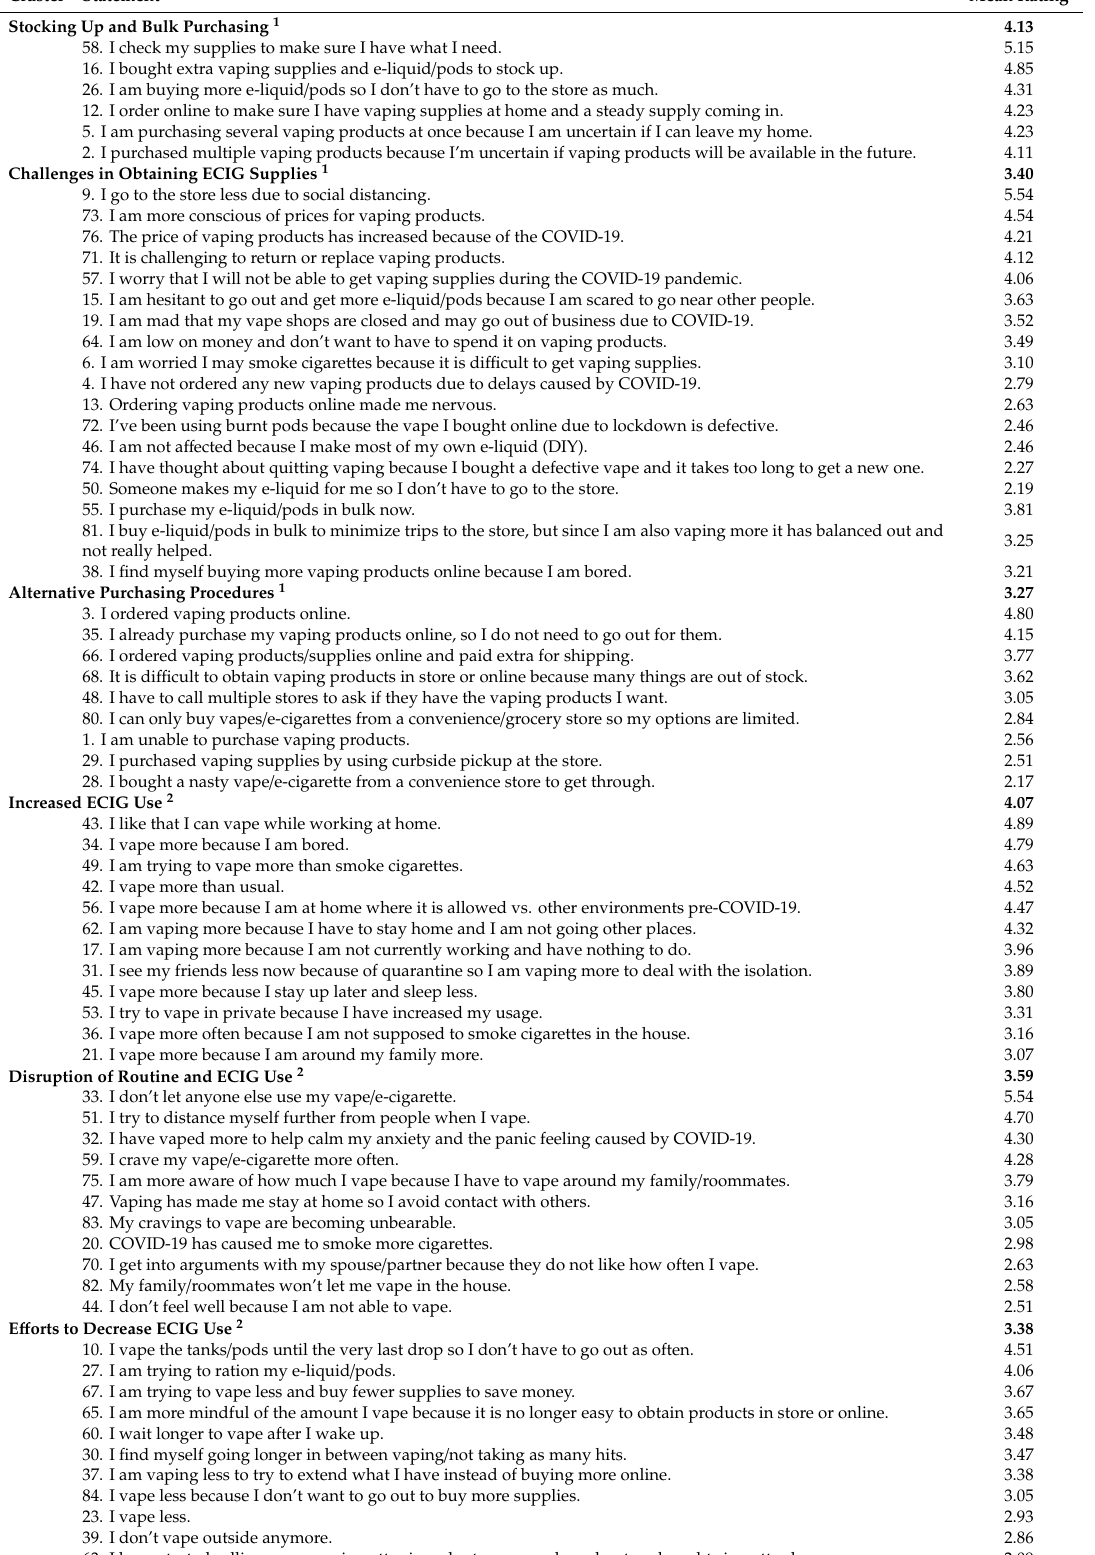
Table 2. ECIG user-identified clusters and statements describing the impacts of COVID-19 on